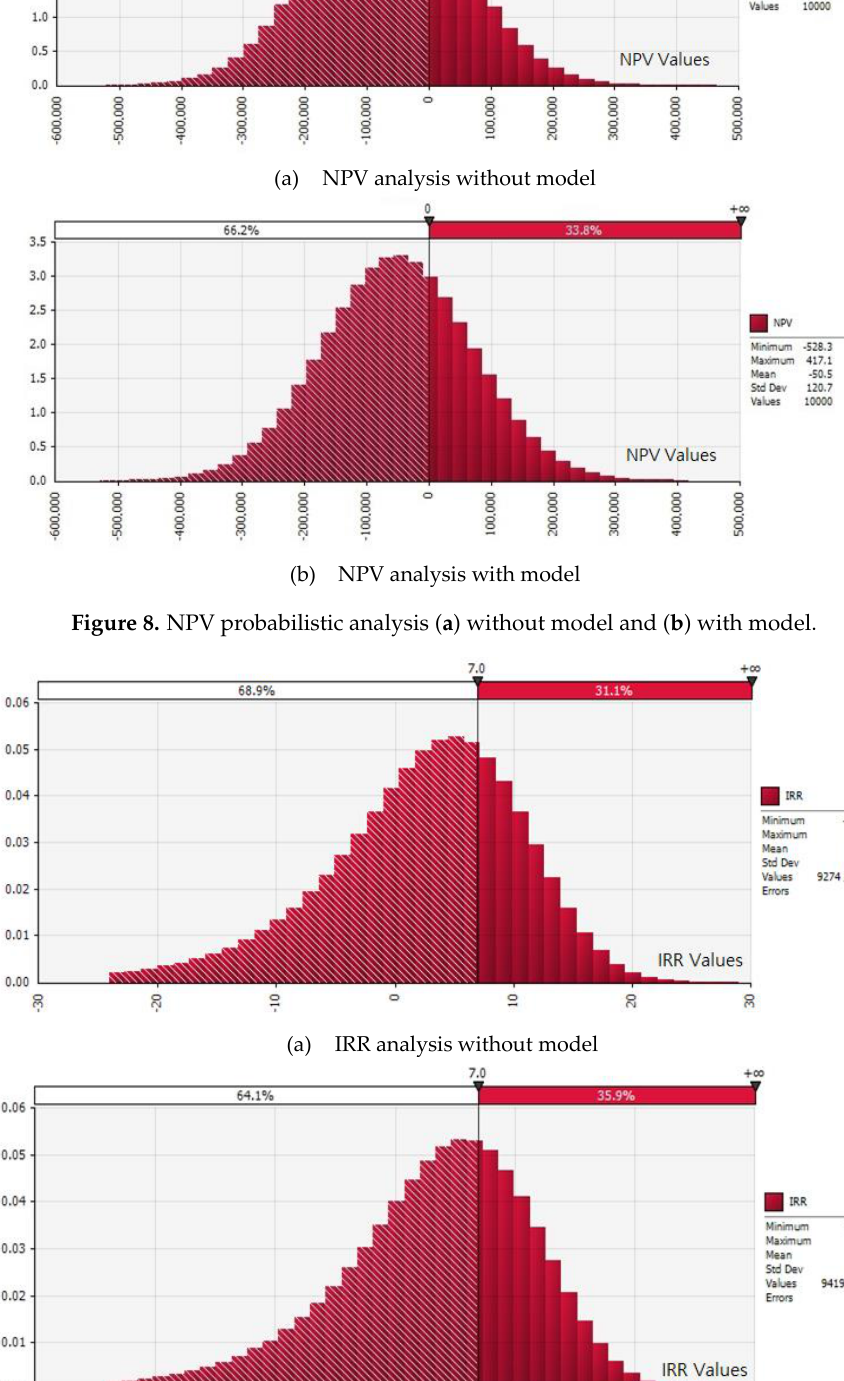
Figure 9. IRR probabilistic analysis (a) without model and (b) with model